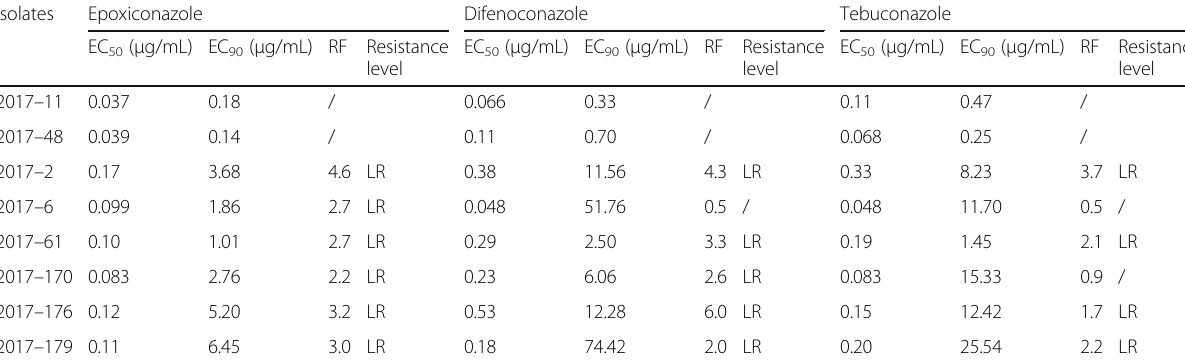
Table 3 Cross-resistance of propiconazole-resistant isolates of Ustilaginoidea virens to other DMIs Isolates Epoxiconazole